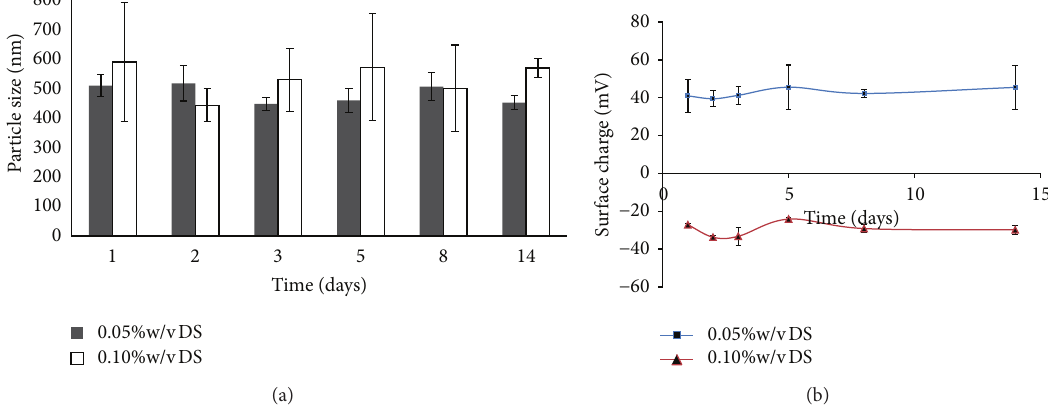
Figure 4: (a) Particle size and (b) surface charge of CS NPs prepared at 0.05 and 0.10% w/v and stored at 4 ∘ C. Nanoparticles were suspended in distilled water (pH in the range of 6-7), 𝑛 = 3